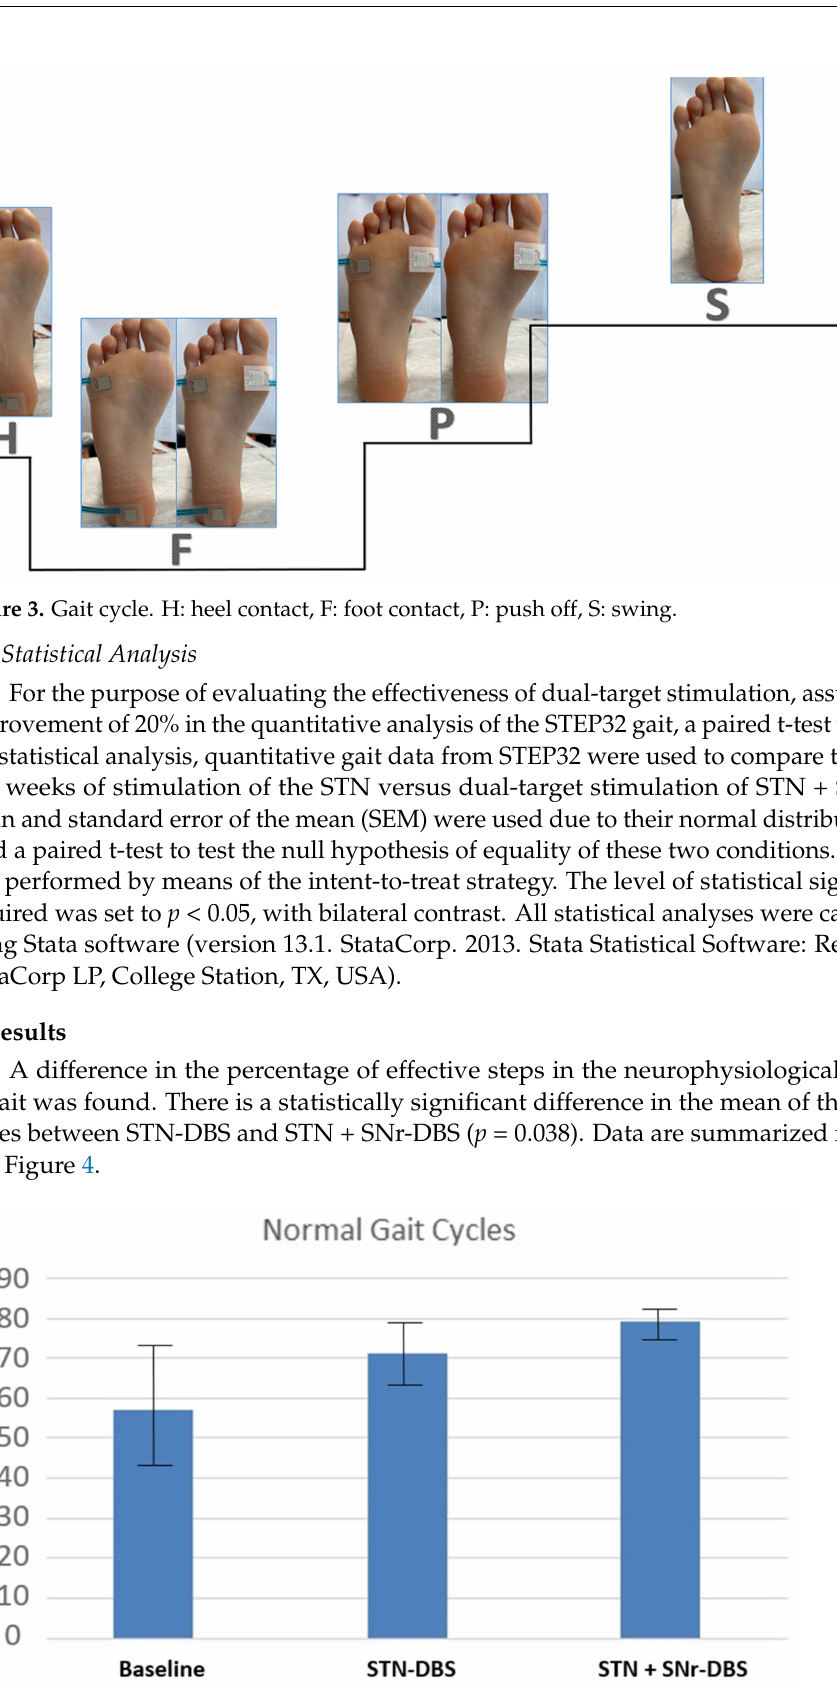
Figure 4. Differences of mean between baseline and the different STN parameters in percentage of cycles with the right sequence (HFPS). STN: Subthalamic nucleus stimulation; STN + SNR: Dual Subthalamic and nigral